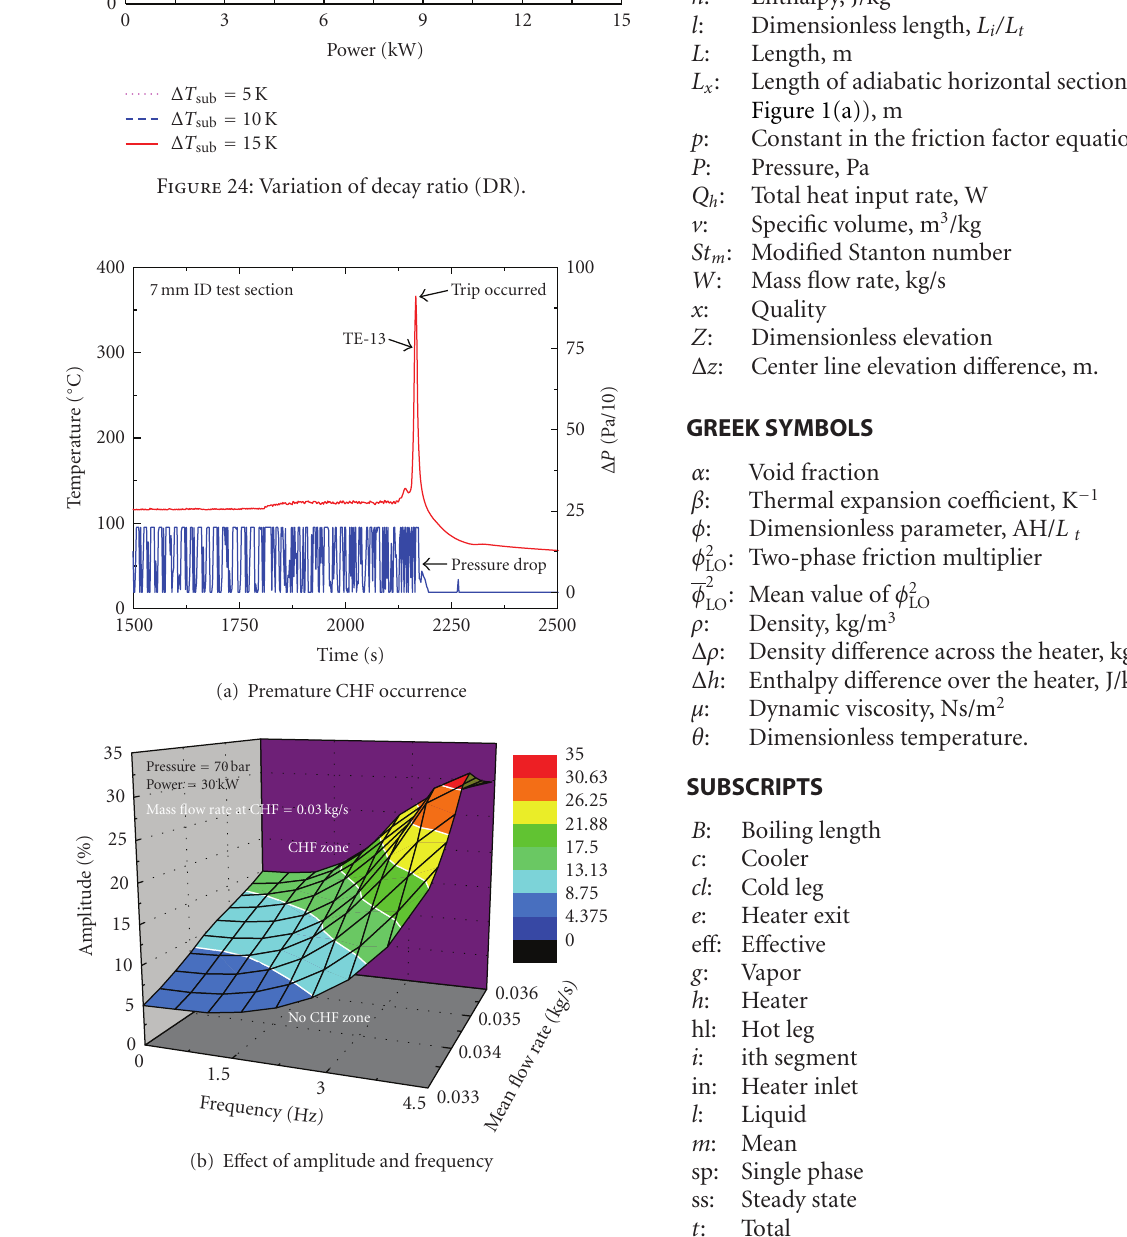
Figure 25: Premature CHF occurrence with oscillatory